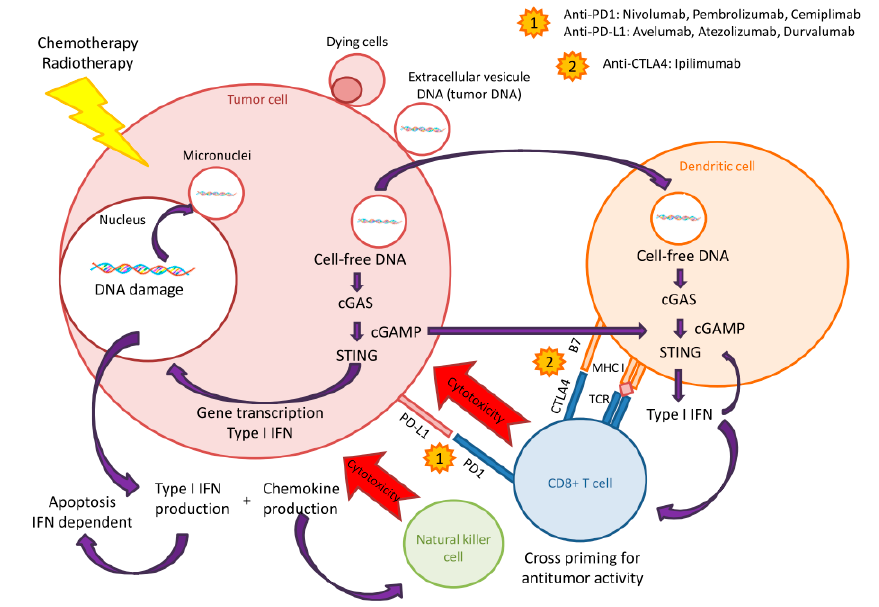
Figure 2. Sting/cGas Pathway. Figure 2. Sting / cGas